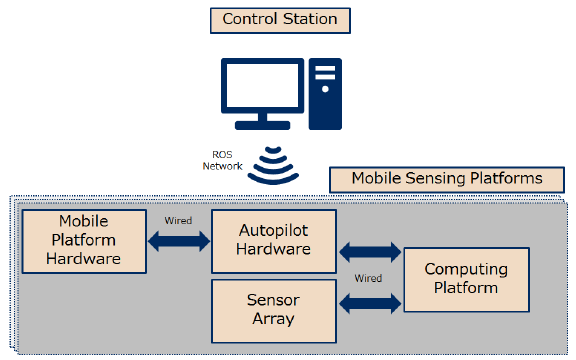
Figure 3. A conceptual overview over the mobile sensing platform (the hardware is shown in Figure